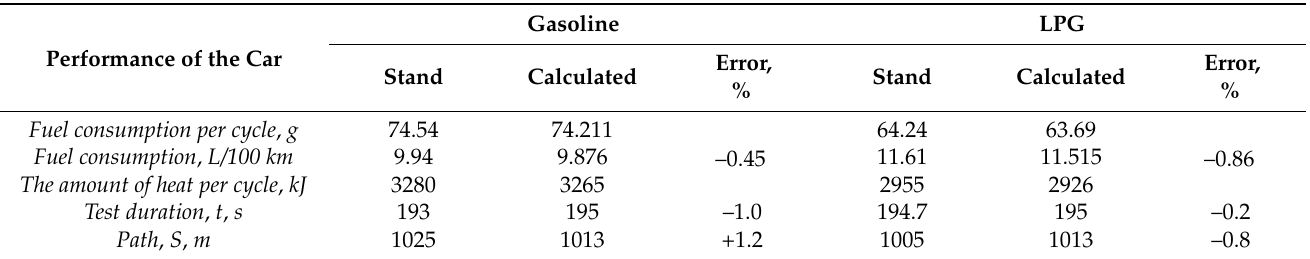
Table 2. Results of experimental and computational studies of fuel consumption of Daewoo Lanos according to the modes of the European urban driving cycle.